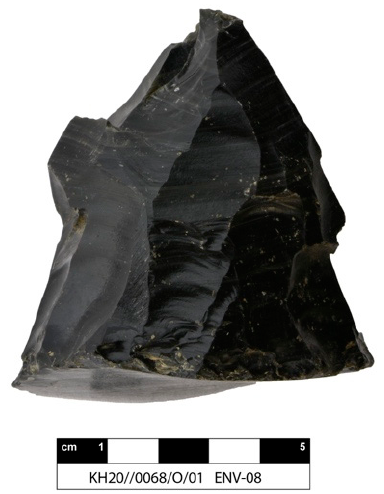
Figure 3. Unipolar pyramidal blade core sample.